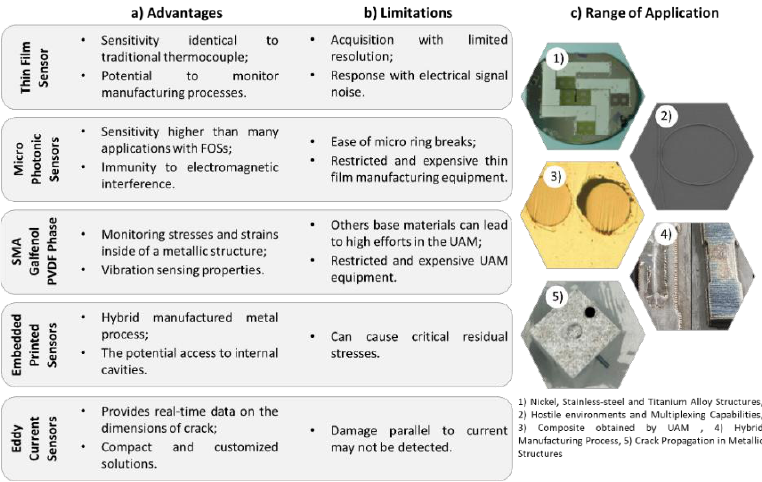
Figure 9. Other embedded sensors for metal